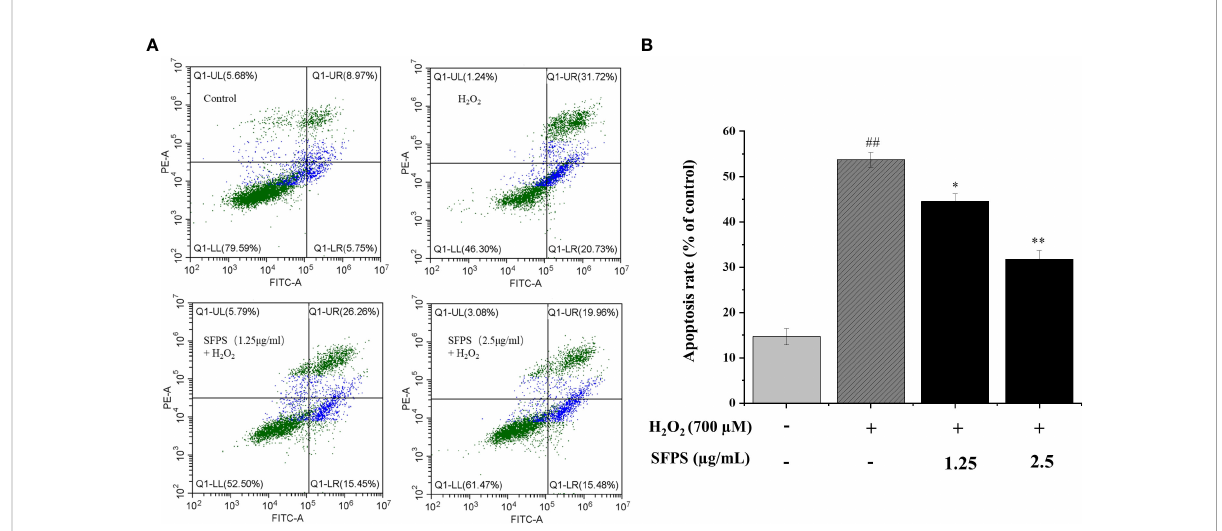
FIGURE 5 In fl uence of SFPS on H 2 O 2 -induced LO2 cell apoptosis. (A) LO2 cells were preincubated with SFPS (1.25 and 5 µg/mL) for 12 h before the treatment with H 2 O 2 for 3 h. Then, LO2 cells were collected and co-stained with Annexin V and PI for 10 min. The upper right quadrants and lower right quadrants represent the ratios of late apoptotic cells early apoptotic cells, respectively. (B) Effect of SFPS on the apoptosis rate of H 2 O 2 -treated LO2 cells. p < 0.01 (**) or p< 0.05 (*) means that columns between H 2 O 2 group and SFPS groups are signi fi cantly different. p< 0.01 (##) means that columns between the control group and the H 2 O 2 group are signi fi cantly